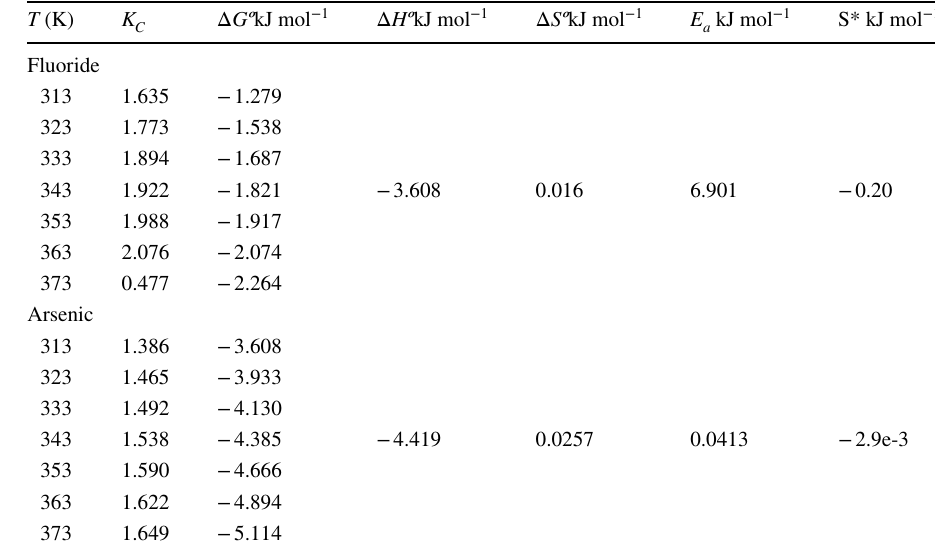
Fig. 7 Plots showing a effect of temperature on adsorption capacity of Fe-KWC b plot of ln K (black-shaded square) and arsenic (blue-shaded circle)